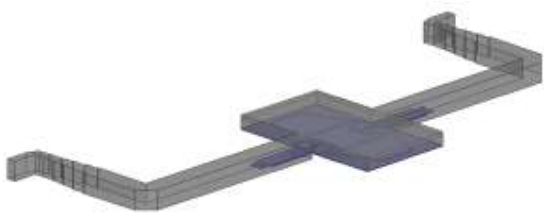
Figure 9: Simulated 3D quarter section of the WR28 SPC.